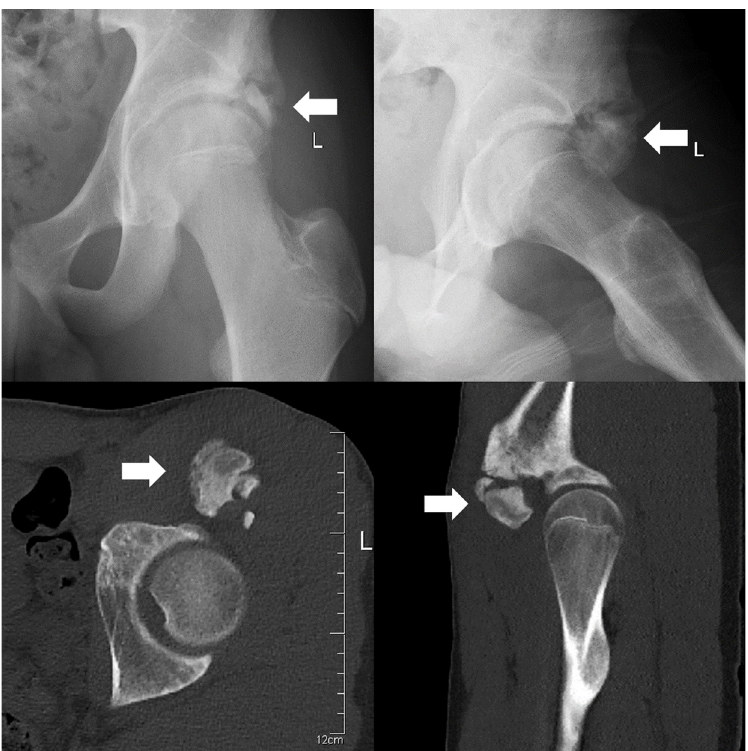
Figure 1. Pre-operative radiograph and CT scan. Arrows show the area of heterotopic ossi fi cation that occurred in the rectus femoris muscle near the origin of the anterior inferior iliac